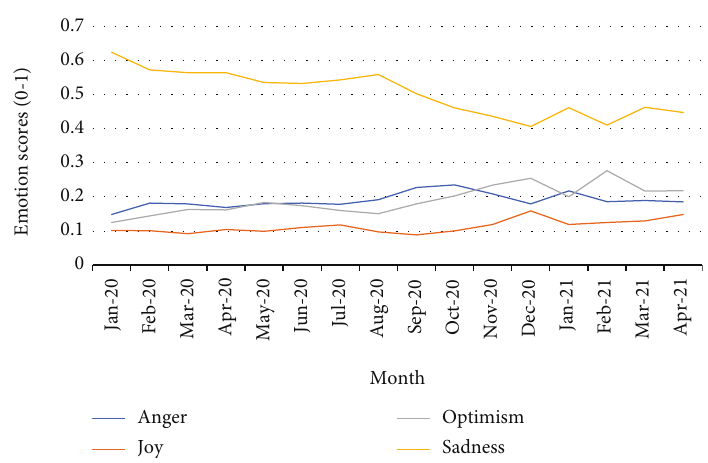
Figure 3: Chart showing monthly average emotion scores across the BBC News (UK) news tweets over time.